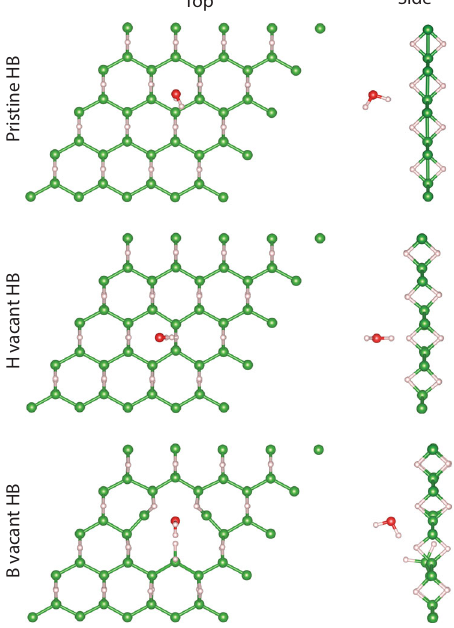
Fig. 5 Optimized structure of the water-adsorbed pristine, H-vacant and B-vacant HB sheet. The water molecule prefers to be in a tilted con fi guration with one H near an active site. The red, green, and white beads refer to the oxygen, boron, and hydrogen atoms, respectively.